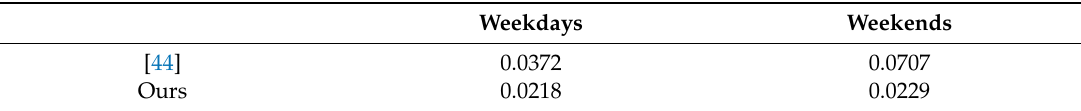
Table 1. Performance comparison of community detection using the modularity metric (low-level